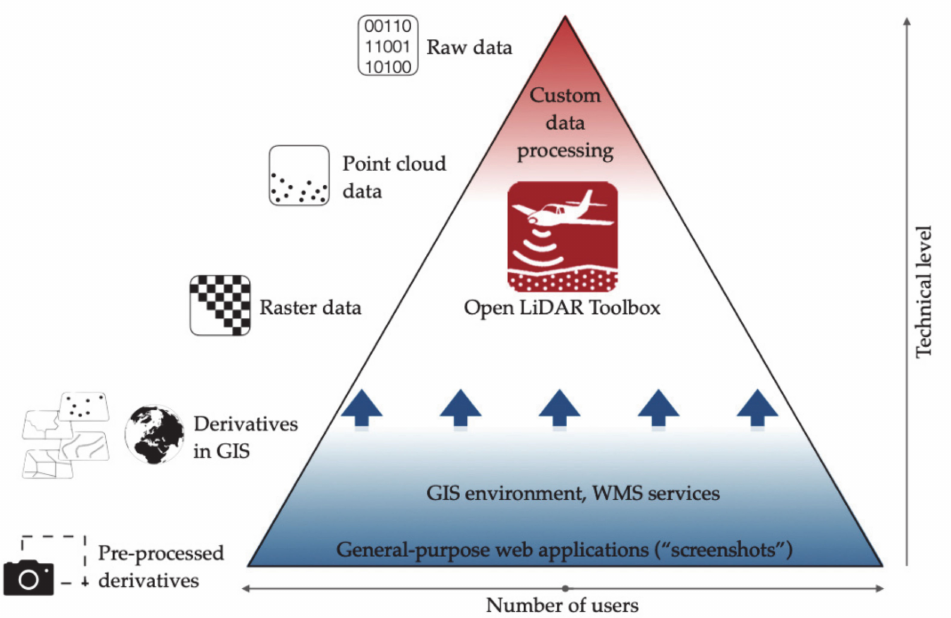
Figure 19. Positioning of the Open LiDAR Toolbox within the archaeological community, which is currently split between specialists (red) and archaeologists consuming data derivatives (blue) with a noticeable gap between the two